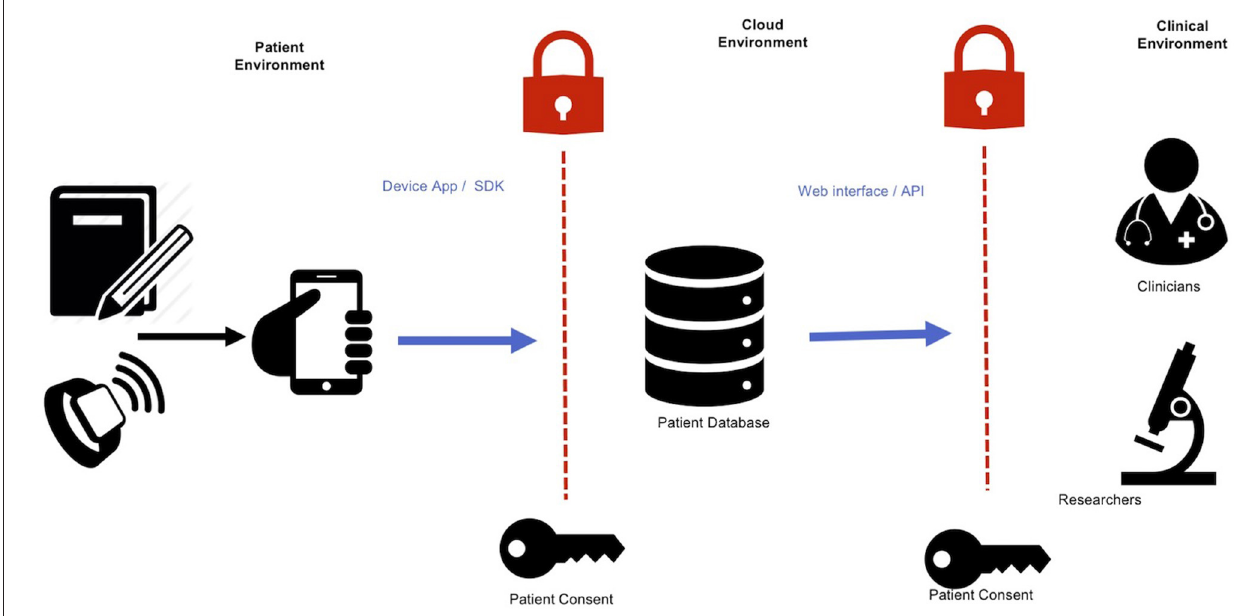
FIGURE 2 | Integrating device data into online accessible databases. An abundance of data relating to physiology, behavior, and environment can be collected with wearable devices and smartwatches. These can then be collected into a single repository in cloud-based data storage. These data can then be accessed by relevant